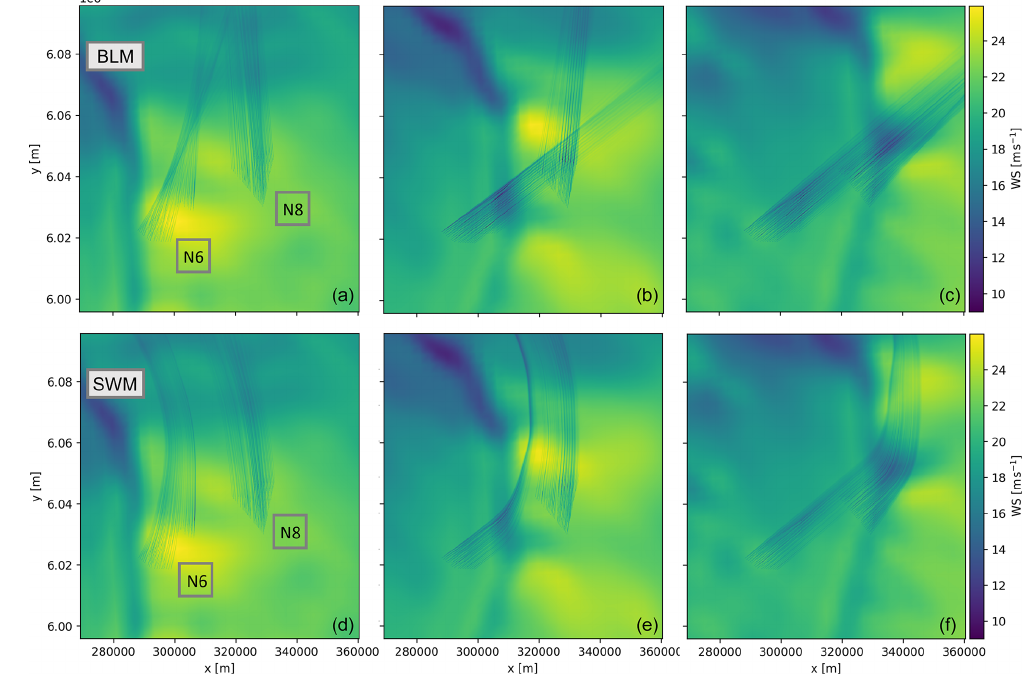
Figure 8. Cluster wakes of the N6 and N8 clusters in the German Bight, modeled with the baseline model (a–c) and the new streamline wake model (d–f) . The situation chosen is the passage of a cold front captured in the mesoscale data of the NEWA on 13 September 2017. The wind speed [ms − 1 ] at hub height is shown from left to right for the following times: 05:00:00, 05:30:00 and 06:00:00UTC. The coordinates are given in UTM format (Zone 32U) with meters easting on the x axis and meters northing on the y